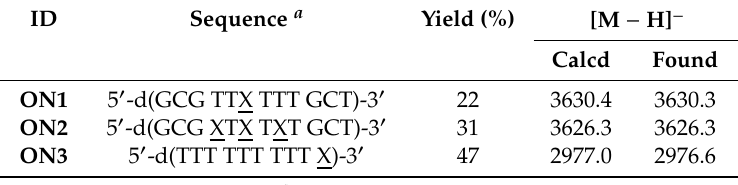
Table 1. Isolated yields of OxNorNA-U-modified oligonucleotides, together with matrix-assisted laser desorption / ionization-time of flight mass spectra (MALDI-TOF MS)